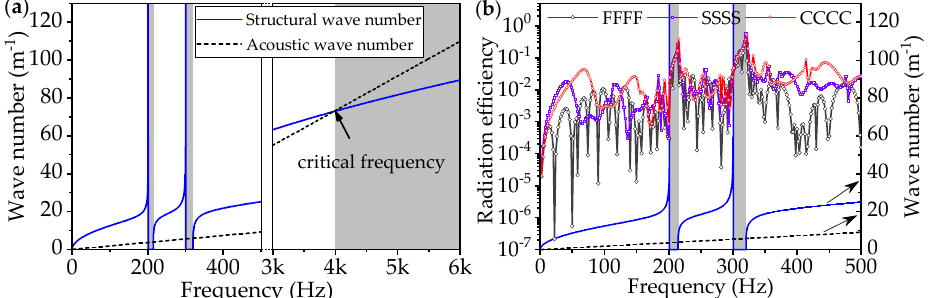
Figure 11. ( a ) The structural and acoustic wave numbers of the infinite locally resonant (LR) plate, and ( b ) the radiation e ffi ciencies of the finite LR plates with undamped resonators ( η R 1,2 = 0), with fully free (FFFF) boundary conditions, fully simply supported (SSSS) boundary conditions, and fully clamped (CCCC) boundary conditions, together with the wave numbers for comparison.